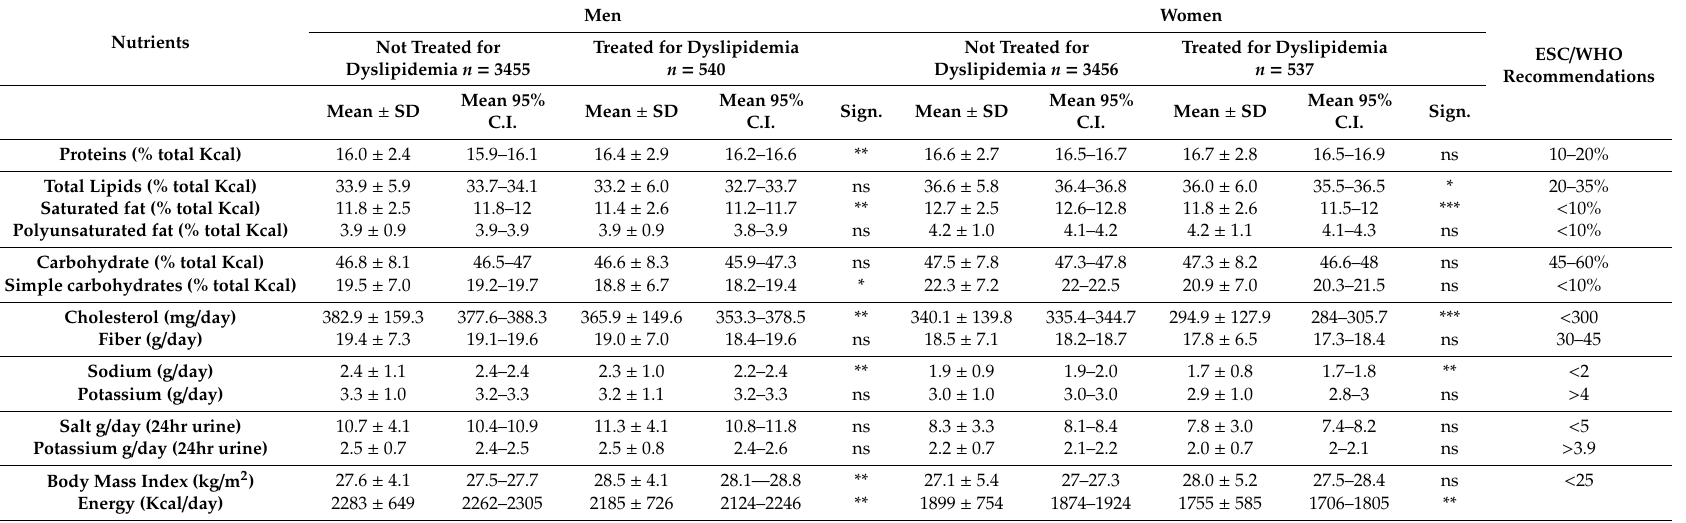
Table 2. Nutrients composition of the diet in men and women receiving and not receiving treatment for dyslipidemia. Men and women aged 35–79 years from the Osservatorio Epidemiologico Cardiovascolare / Health Examination Survey of the CUORE Project